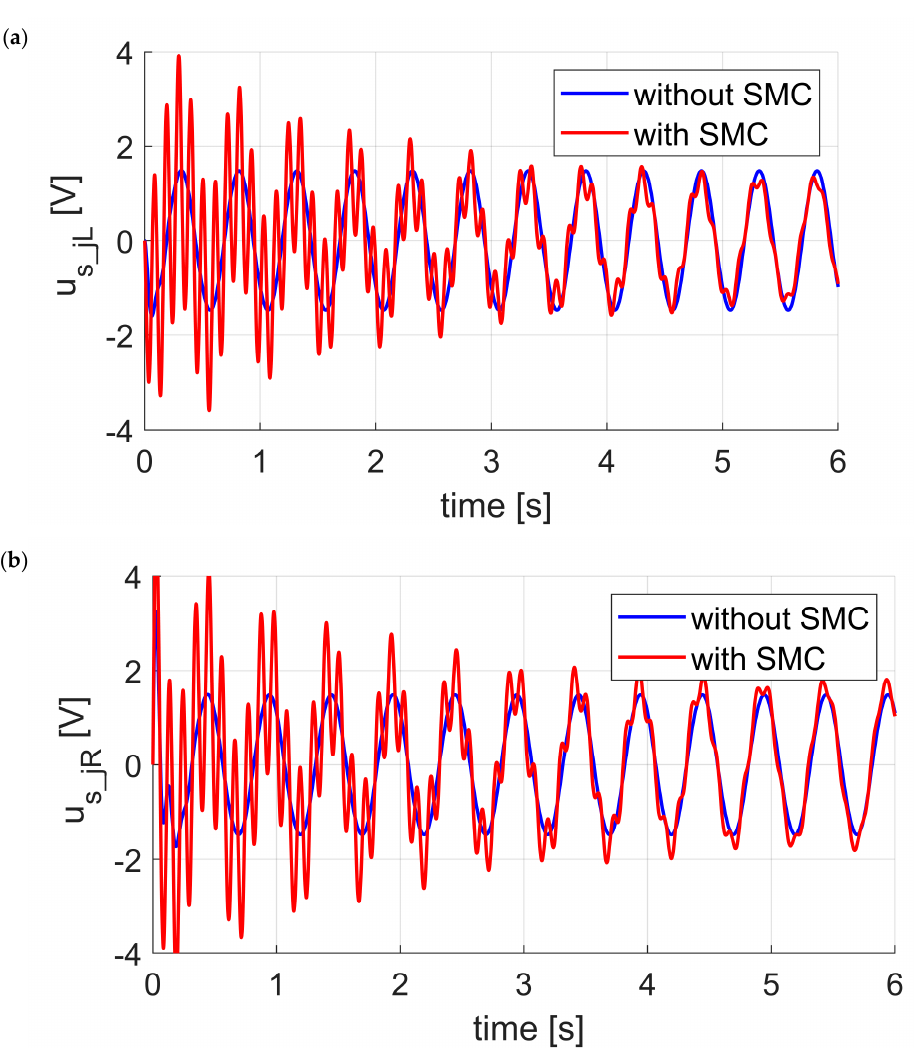
Figure 5. Comparison of struts control signals with and without SMC for left strut ( a ) and right strut ( b ) for A w _ jR = A w _ jL = 0.01 m, f w _ jR = f w _ jL = 2